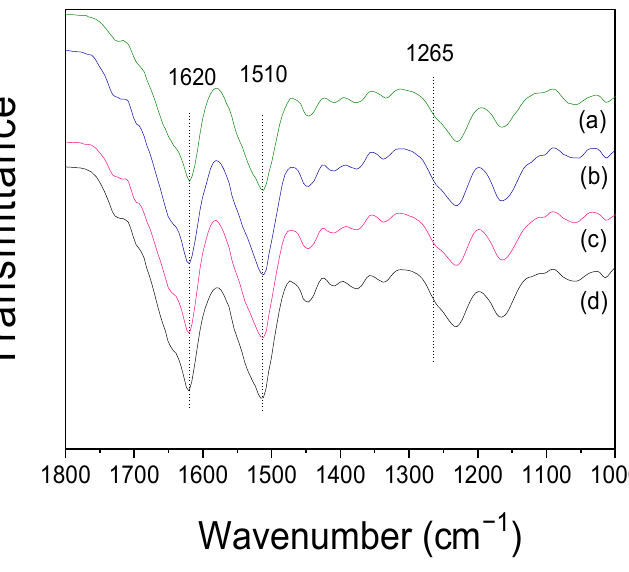
Figure 5. FTIR spectra of the silk nanofibril/RSF composite film containing different amounts of silk nanofibrils; ( a ) 0%, ( b ) 5%, ( c ) 10%, and ( d ) 15%.